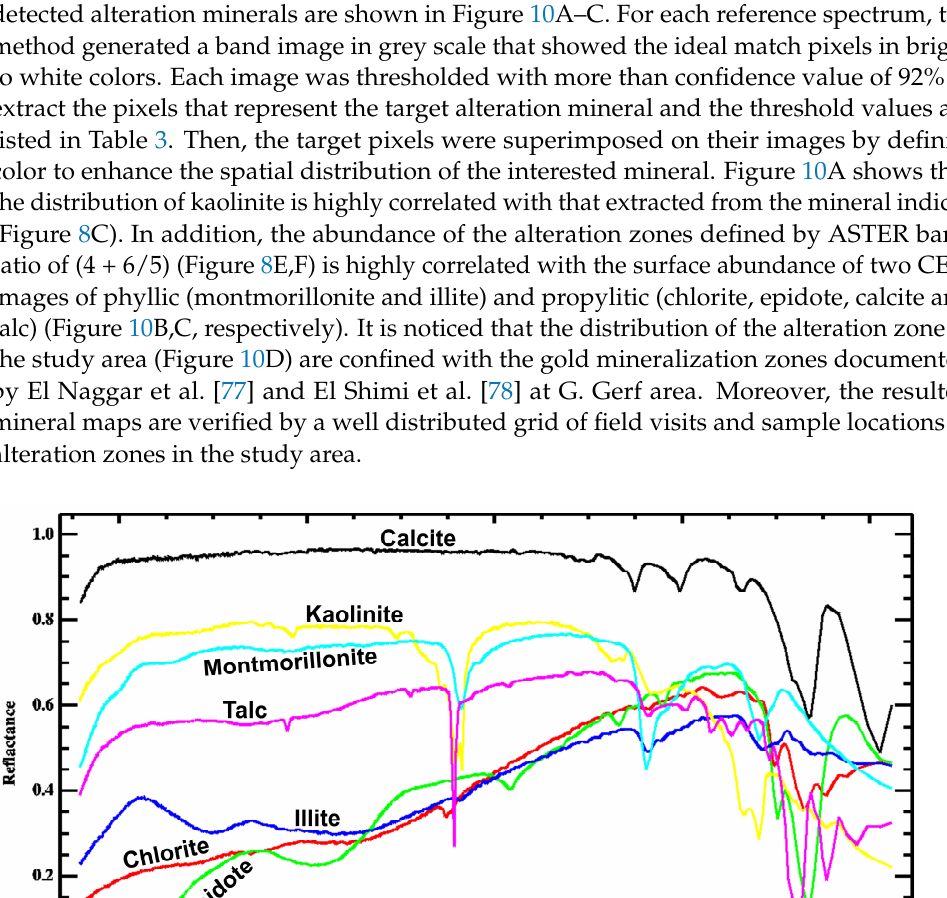
Figure 10. The surface abundance of alteration zones resulted from CEM mineral mapping tech- nique ( A ) argillic (kaolinite), ( B ) phyllic (illite-montmorillonite, ( C ) propylitic (chlorite-epidote-cal- cite-talc) and ( D ) the grouped alteration zones in the study area.